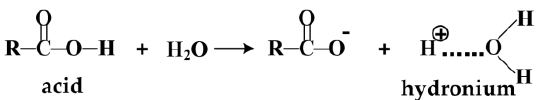
Figure 9. The principle of cellulose acid hydrolysis reaction.